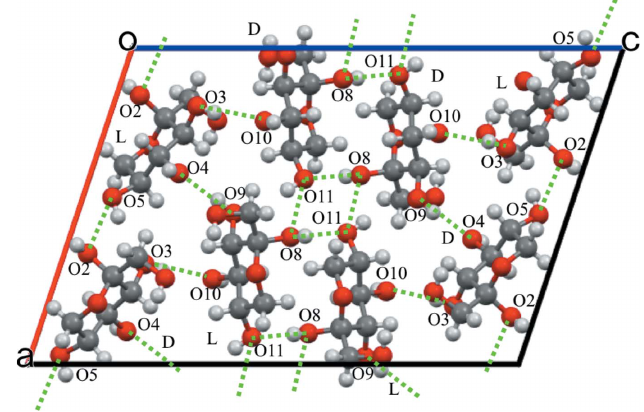
Figure 1 An ORTEP view of the title compound, molecule A (left) and molecule B (right), with the atom-labelling scheme. Displacement ellipsoids are drawn at the 50% probability level. H atoms are shown as small spheres of arbitrary